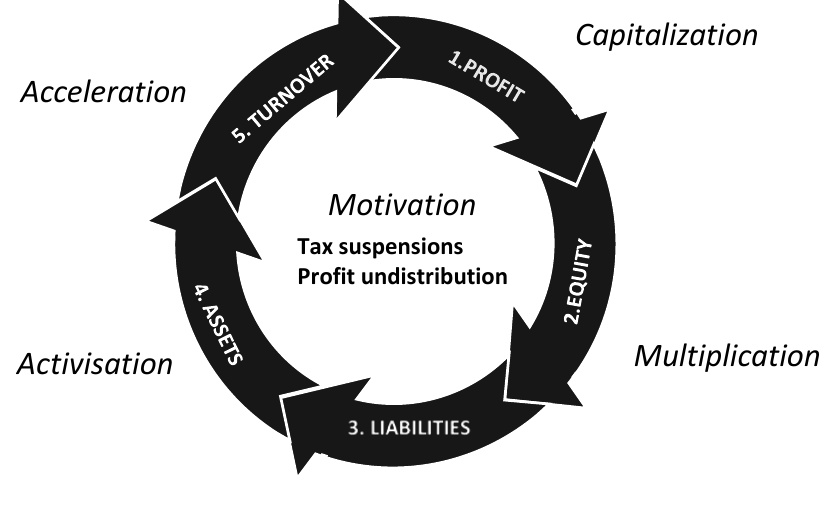
Fig. 2. Impact of tax suspensions on the financial performance of businesses (made by the